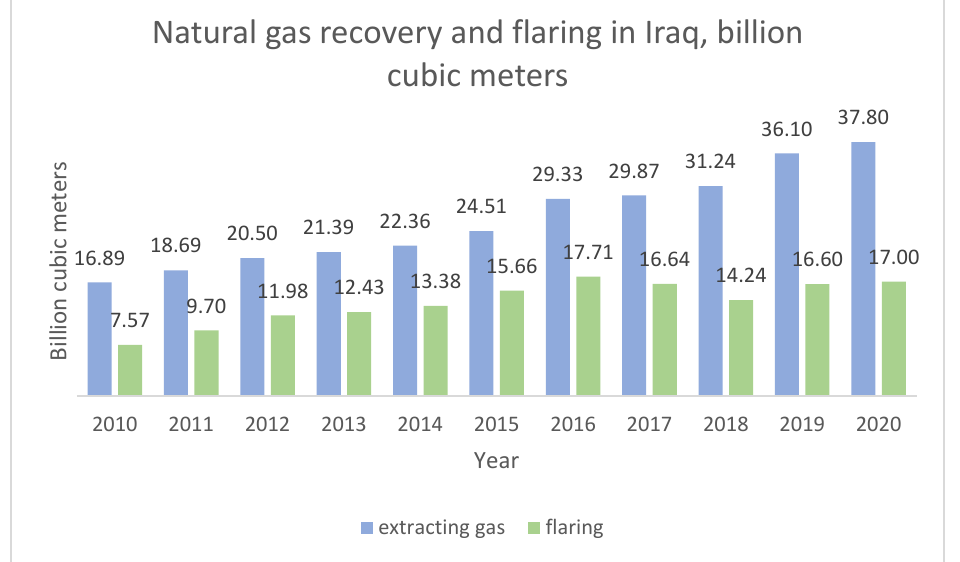
Figure 2. Natural gas recovery and flaring in Iraq, billion cubic meters [19–21].